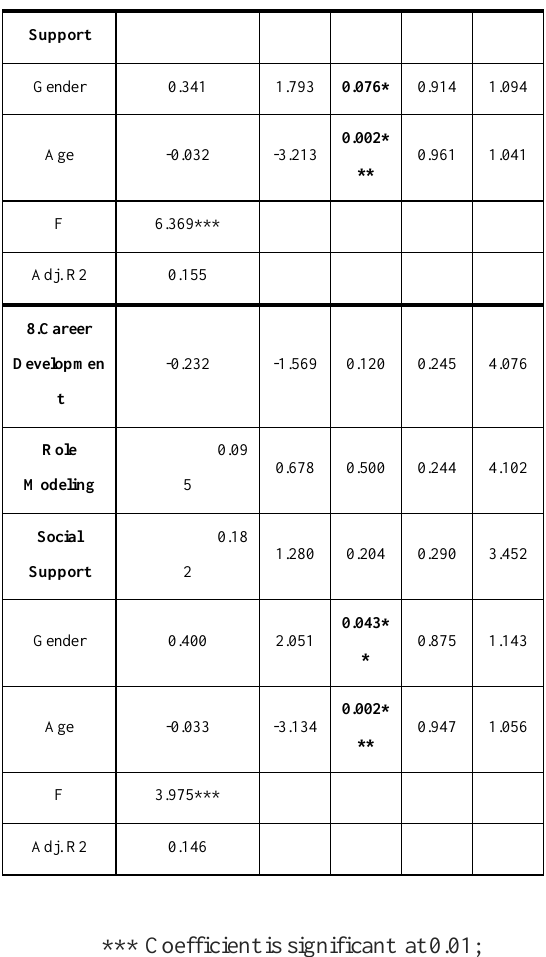
Table above shows the effect of mentoring (career development, role modeling, social support) and control variables (gender and age) on the continuance commitment. Model 5 provides the effect of career development gender and age on the continuance commitment. The model had a positive and statistically significant